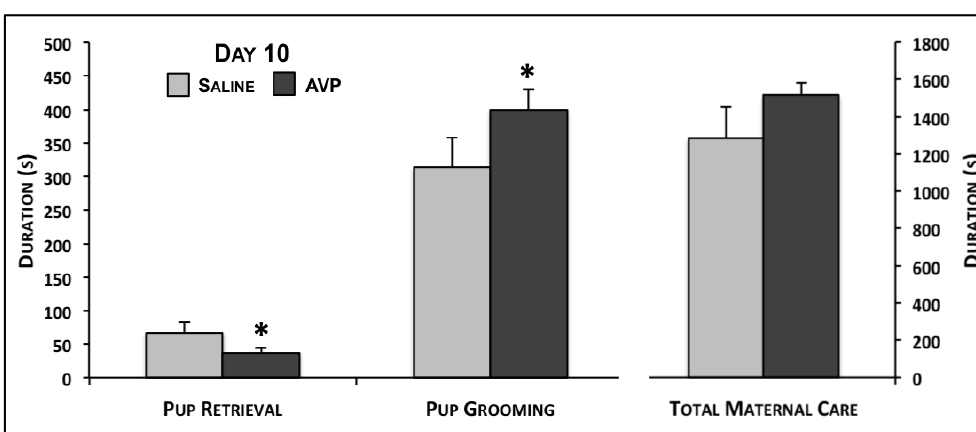
Figure 1. Mean + SEM duration values for pup retrieval, pup grooming and total maternal care (sum of pup grooming and nursing) on day 10 of lactation during a 30 min maternal care observation test of chronic social stressed dams treated with either saline or AVP. * indicates a significant difference between treatments ( p ≤